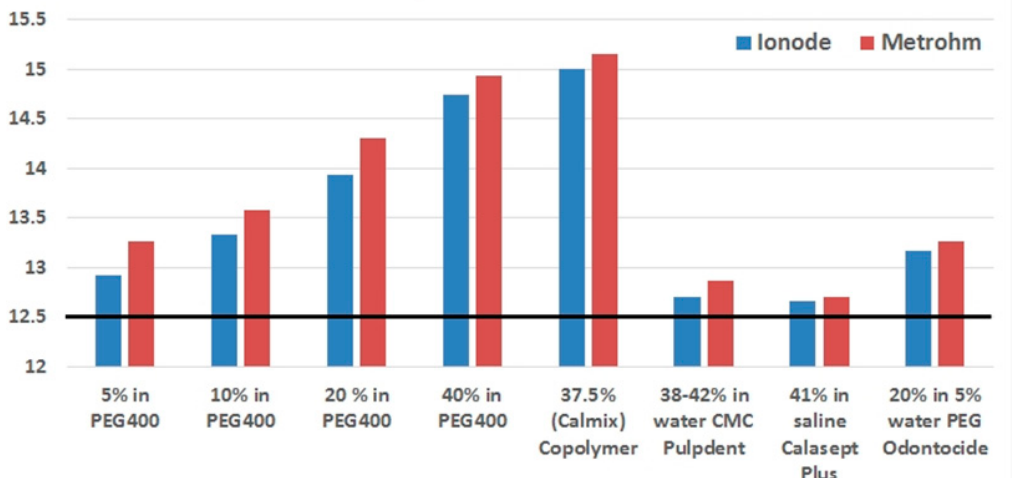
Figure 1. pH measurements using a KCl electrode (Ionode) (blue bars) and a tetraethylammonium bromide (TEABr) electrode (Metrohm Solvotrode)(model, company, city, country) (red bars)